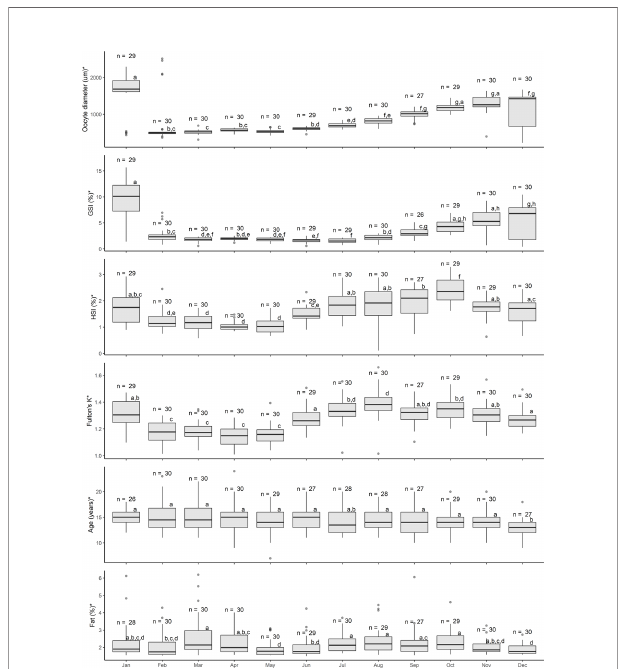
FIGURE 3 | Temporal assessment of oocyte size (diameter in µm), gonadosomatic index (GSI, %), hepatosomatic index (HSI, %), Fulton ’ s condition factor (K), age (years), and somatic fat (%) of female Paci fi c halibut during an entire calendar year. For each parameter statistical signi fi cance (p < 0.05, Kruskal-Wallis) was denoted with an * in the y-axis title, with different letters indicating statistically signi fi cant (p < 0.05, Dunn ’ s post hoc ) differences among groups (e.g. “ a ” is different from “ b ” but not from “ ab ” ), and with the sample size displayed above the